Question: Briefly state, in one sentence, what is plotted here.
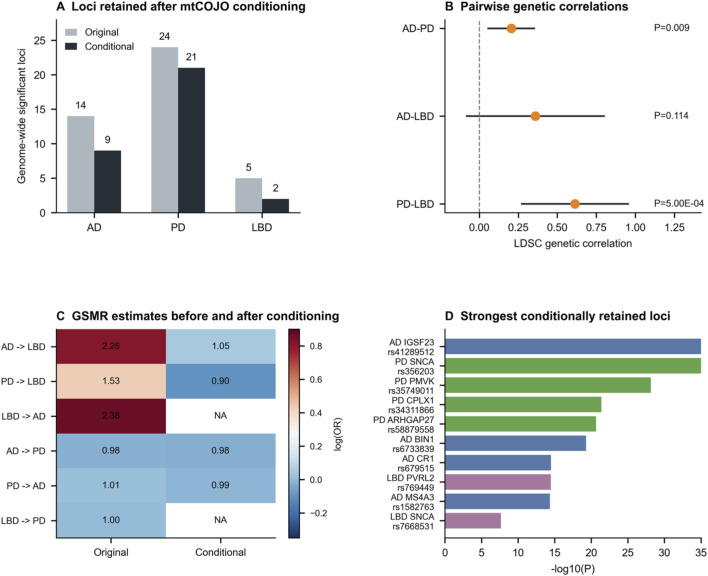
Answer: Cross-disorder genetic sharing and conditionally retained GWAS signals. (A) Genome-wide significant locus counts in original and mtCOJO-conditioned analyses. Bars show the number of independent genome-wide significant loci before and after conditioning on the other two disorders. (B) Pairwise LDSC genetic correlations among AD, PD and LBD. Points show rg estimates, horizontal lines show 95% confidence intervals and labels show LDSC P values. (C) GSMR cross-trait odds-ratio estimates before and after conditioning. Values are odds ratios; colour indicates log(OR). (D) Strongest conditionally retained loci ranked by -log10(P), with disease colours indicating the target GWAS.